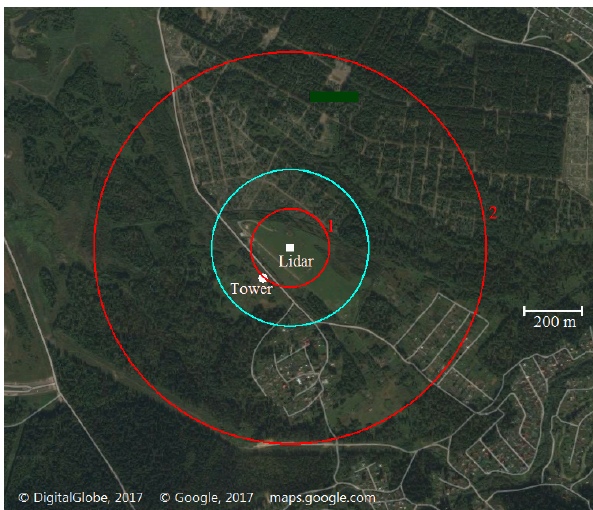
Figure 3. Map of the experimental site in 2014 and 2016. The blue circle shows the trajectory of the lidar sensing volume at a height of 43m during the measurement at the elevation angle ϕ = 9 ◦ in 2014. Red circles 1 and 2 show the trajectories of the lidar sensing vol- ume at heights of, respectively, 100 and 500m during the mea- surement at ϕ = 35.3 ◦ in 2016. Coordinates of the lidar point were 56 ◦ 28 (cid:48) 51.41 (cid:48)(cid:48) N, 85 ◦ 06 (cid:48) 03.22 (cid:48)(cid:48) E.